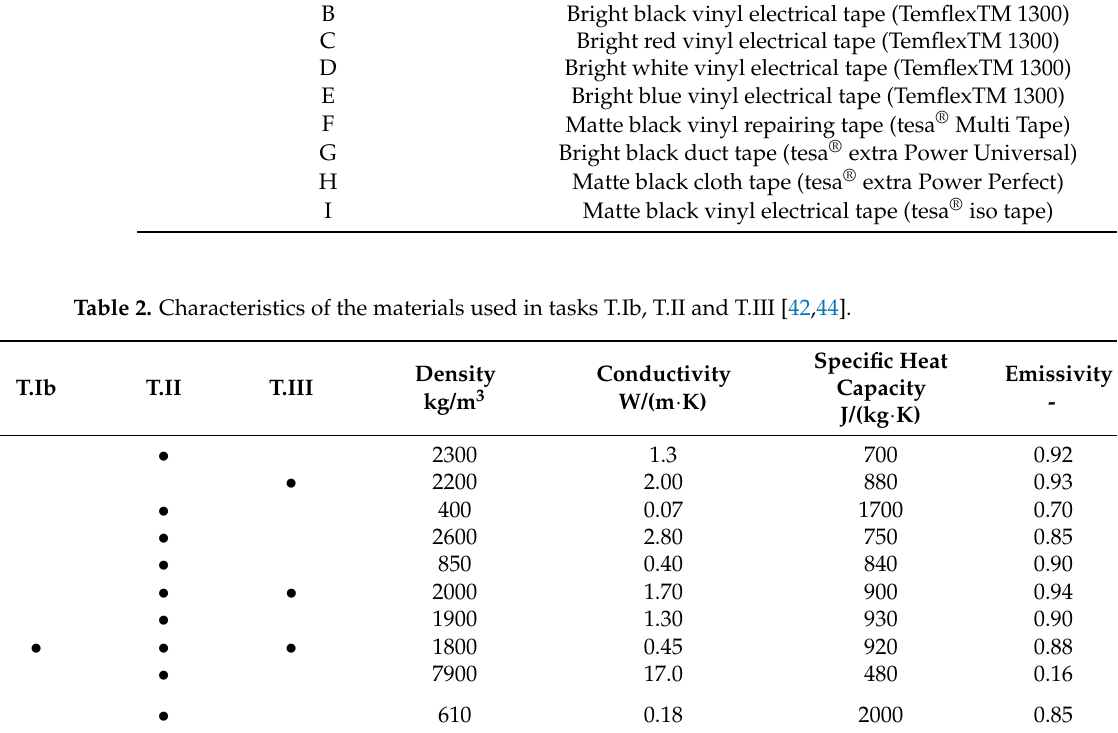
Table 2. Characteristics of the materials used in tasks T.Ib, T.II and T.III [42,44].